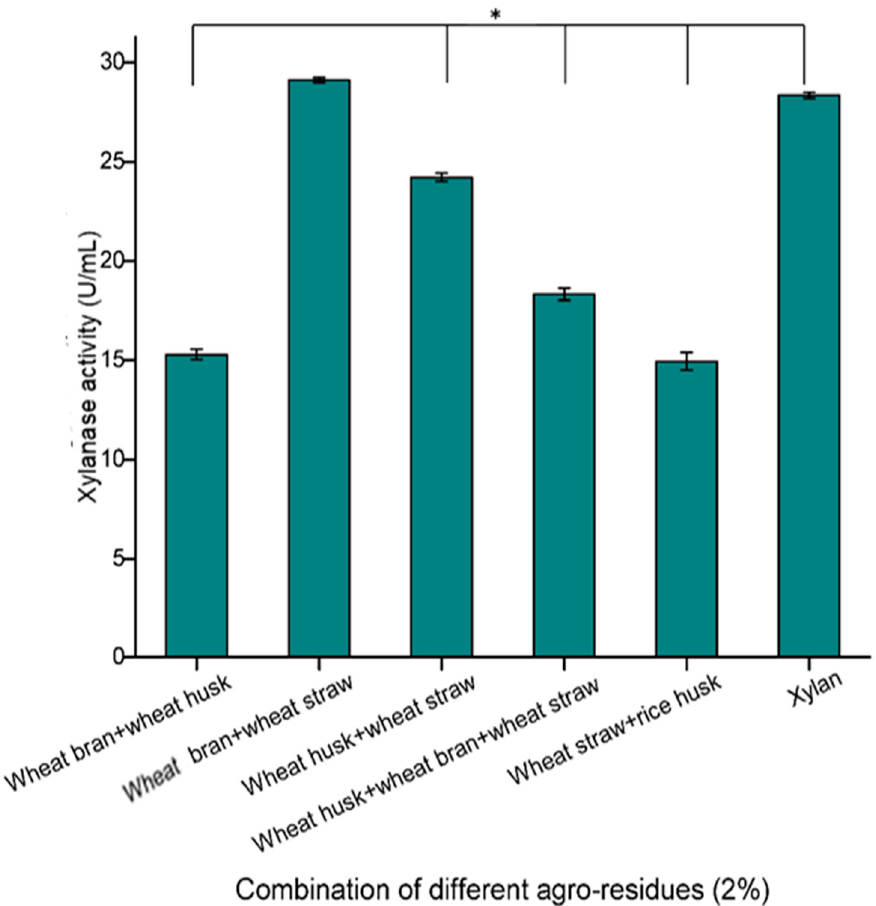
Figure 2. Screening of different types of agro-residues in combination for the production of xylanase by B. safensis XPS7. All the experiments were performed in triplicate. Bars display mean ± SD and statistical analysis was performed using a one-way ANOVA with a Tukey post hoc test, with p < 0.01 *.